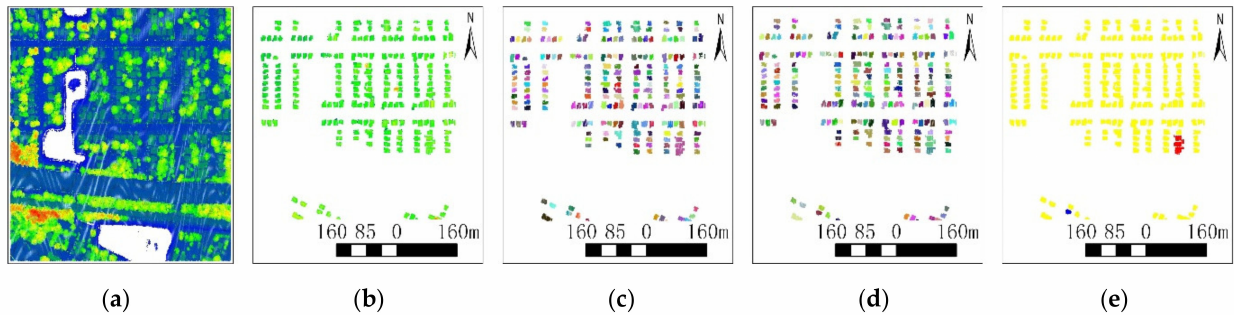
Figure 12. Building instance segmentation result of dataset 5: ( a ) The point clouds of the entire scene displayed in different colors according to their heights; ( b ) the building point clouds; ( c ) the result of UBIS method; ( d ) the ground truth; ( e ) the main differences between the UBIS method result and the ground